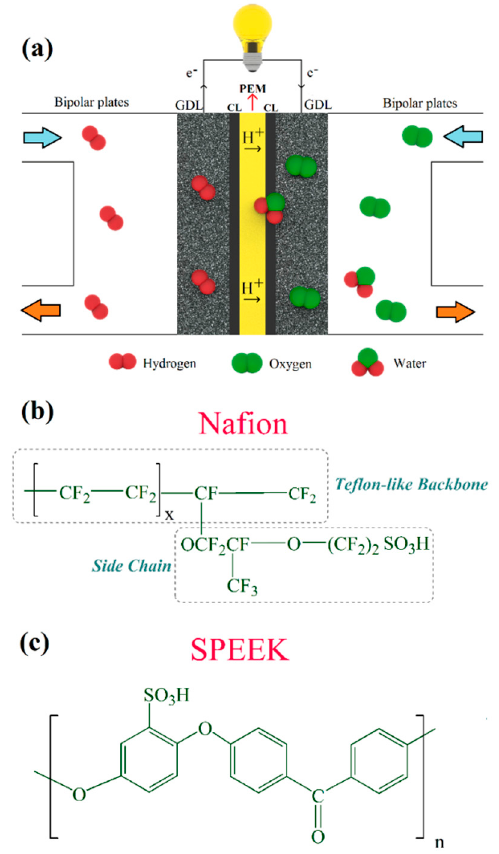
Figure 1. ( a ) Schematic illustration of polymer electrolyte fuel cells (PEFCs) and chemical structure of ( b ) Nafion and ( c ) sulfonated poly(ether ether ketone) (SPEEK) proton exchange membranes (PEMs).